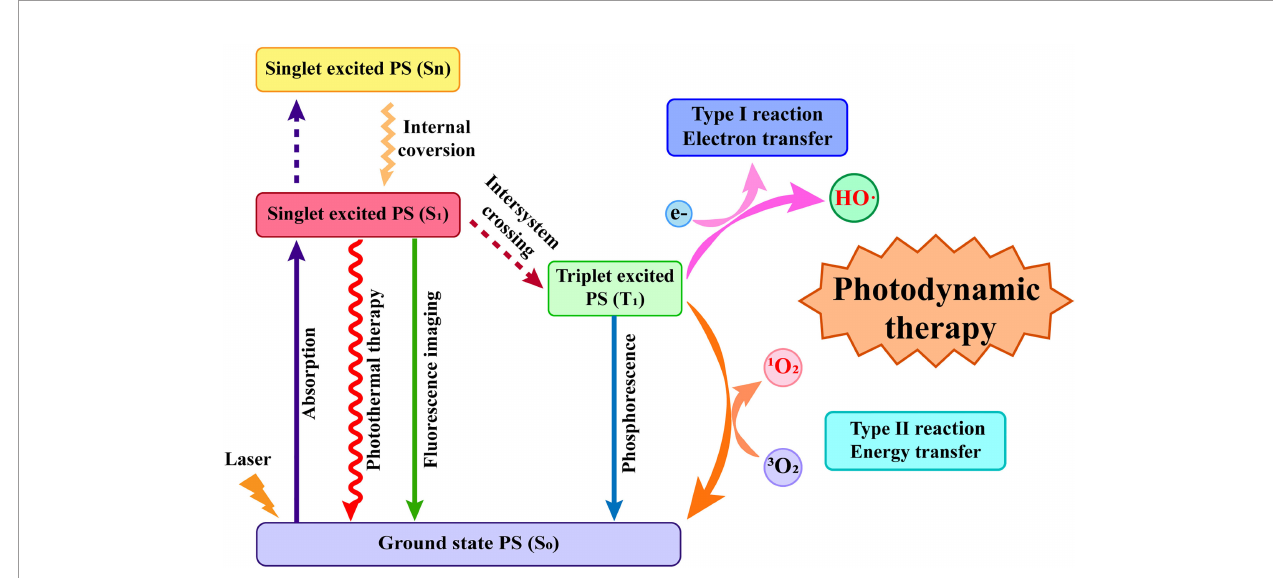
FIGURE 1 | The photophysical mechanism and the two classic types of photodynamic therapy (PDT). The photosensitizer absorbs light energy to jump from the ground state to the excited state, which then leads to a long-lived excited triplet state through intersystem crossing and fi nally generate reactive oxygen species through type I reaction or type II